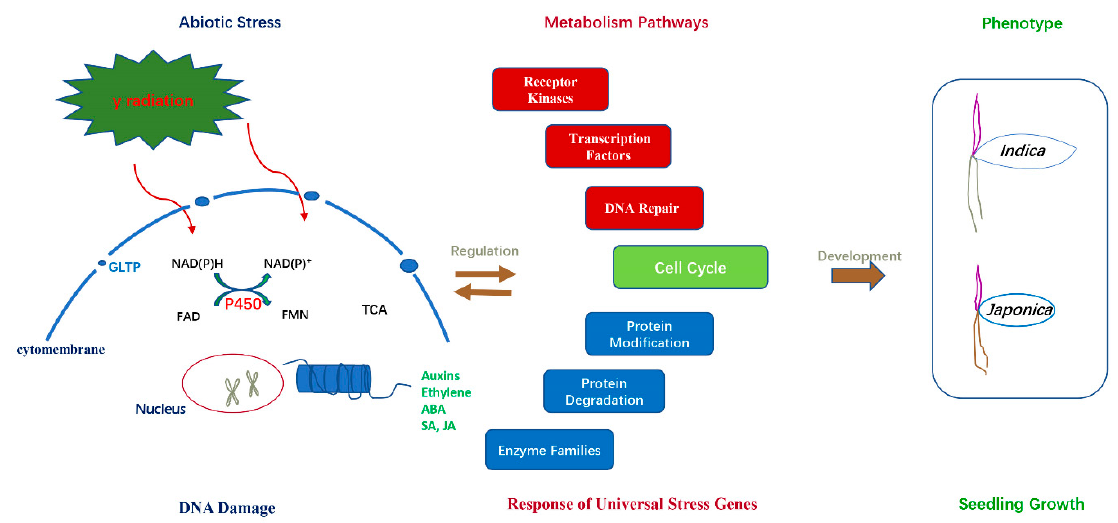
Figure 10. Schematic model for the regulation mechanism in rice plant cells’ response to gamma